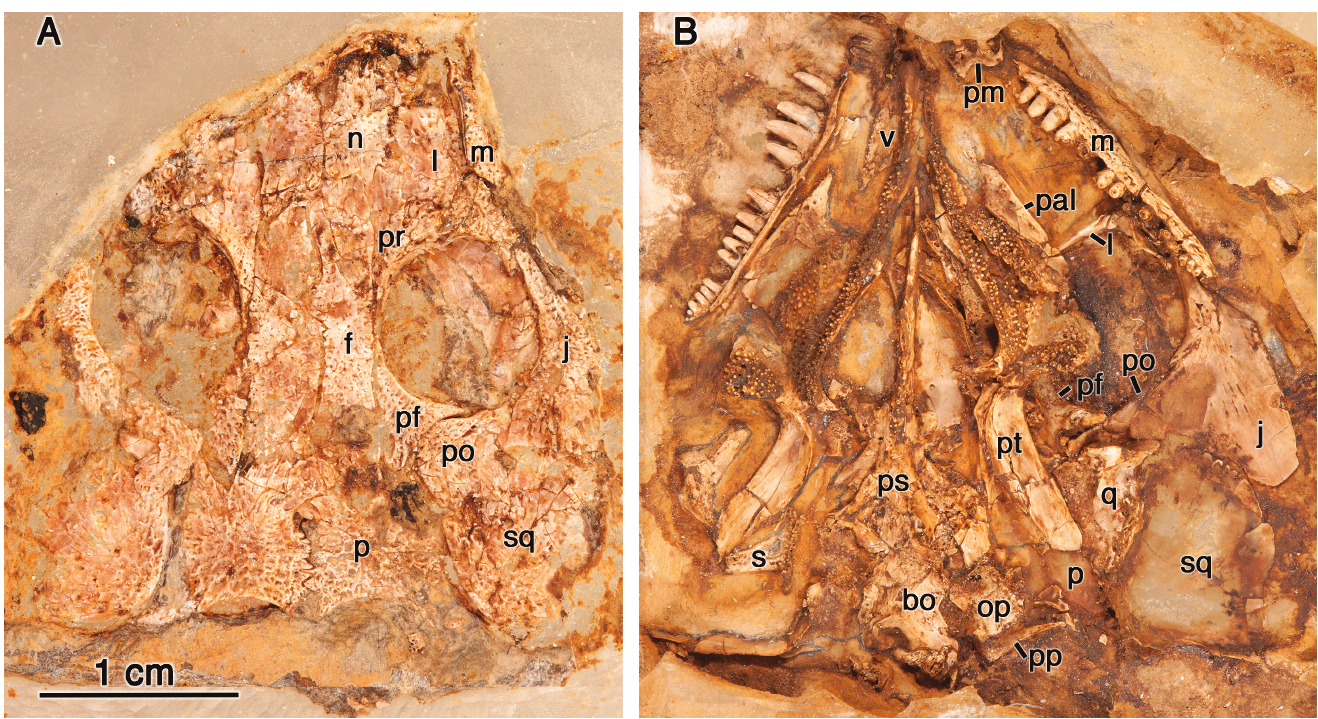
Figure 2. Euconcordia cunninghami , referred specimen KUVP 96164a & b. A, the skull roof preserved in dorsal view. B, its counterpart, skull preserved in palatal view. This specimen was originally erroneously labeled as KUVP 96/64 (Müller and Reisz 2005). Abbreviations as in Figure 1. Scale bars =